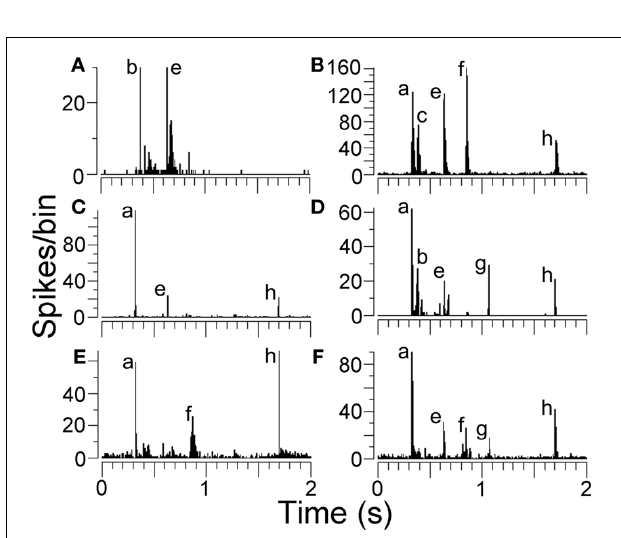
acoustically distinct elements is indicated along with their mean latency relative to the start of the stimulus file given in ms. Most units respond by giving brief increases in their firing rate at times that correspond to one or more of the elements in the call. The firing rate is given as spikes/bin/stimulus repeat.